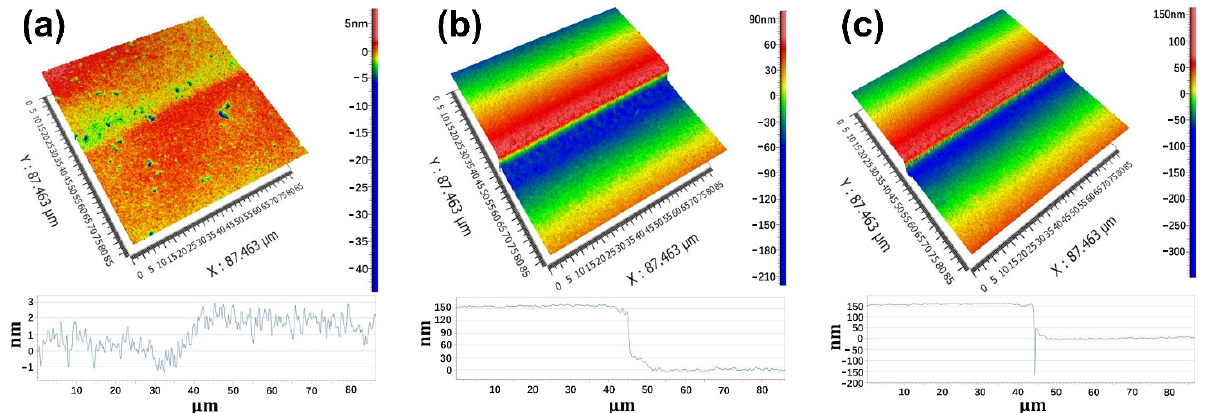
Figure 6. Laser ablation depth under different oxidation durations: ( a ) 5 min, ( b ) 30 min, and ( c ) 60 min.